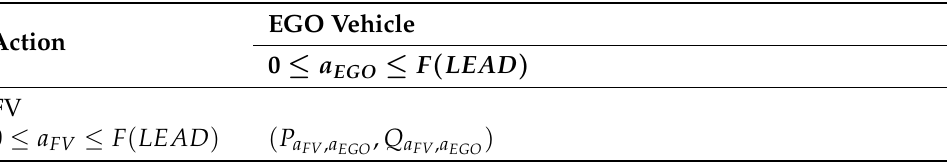
Table 2. Game description in its normal-form representation. EGO and FV denote the players. a EGO and a FV denote the sets of strategies for the EGO and FV, respectively. P a the outcome values of the game with respect to the